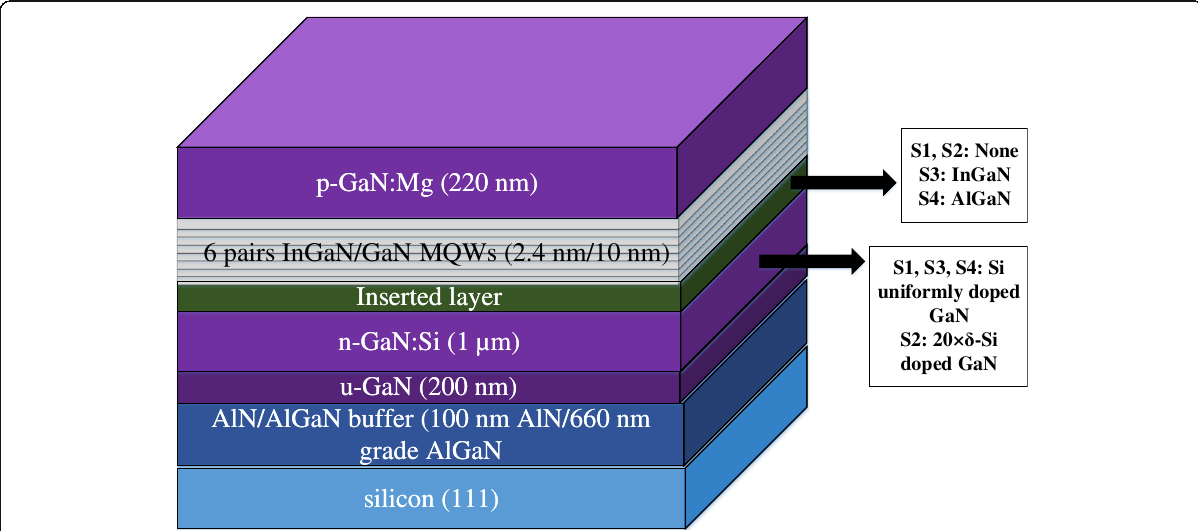
Fig. 1 Structures of the MQW LED samples grown on Si substrates. S1, S3, and S4 contain 1 μ m Si uniformly doped n-type GaN layer. S3 contains 20 nm InGaN inserted layer. S4 contains 20 nm AlGaN inserted layer. S2 contains 20 periods of Si- δ -doped planes each followed by 50 nm nominally undoped GaN with a total thickness of 1 μ m instead of Si uniformly doped n-type GaN